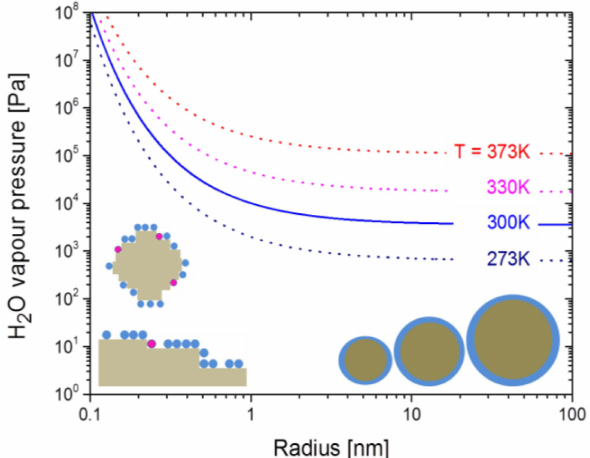
Figure 8. Vapor pressure enhancement over small spheres with radius r relative to a flat water-air interface as predicted by the Kelvin equation [51]. The spheres in the bottom right-hand part indicate water desorption from ideal spheres as considered by the Kelvin equation; the pictures in the left-hand part indicate that real, nanometer-sized crystals will have step-, kink- and terrace-kinds of defects of sub-nanometer